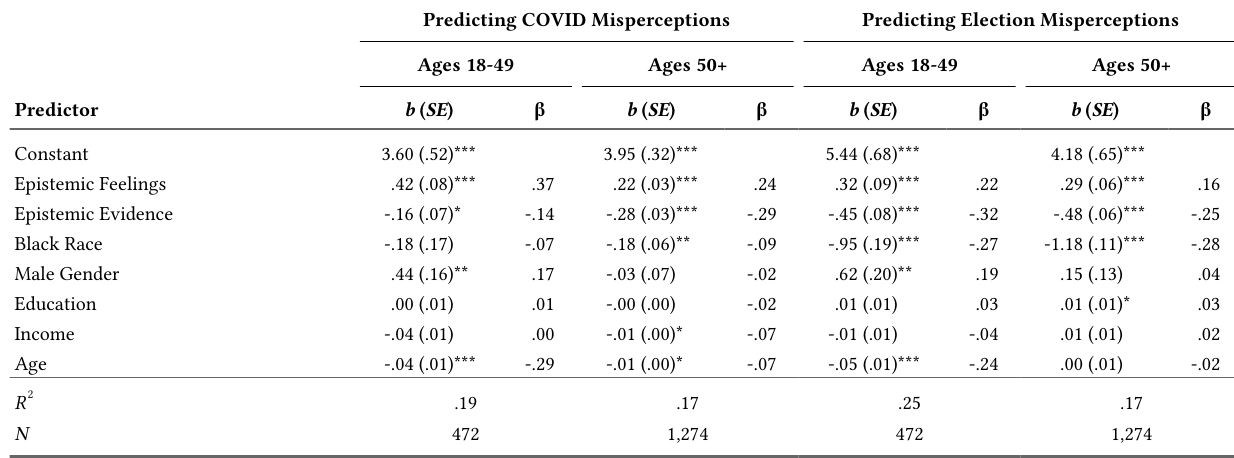
Predicting COVID